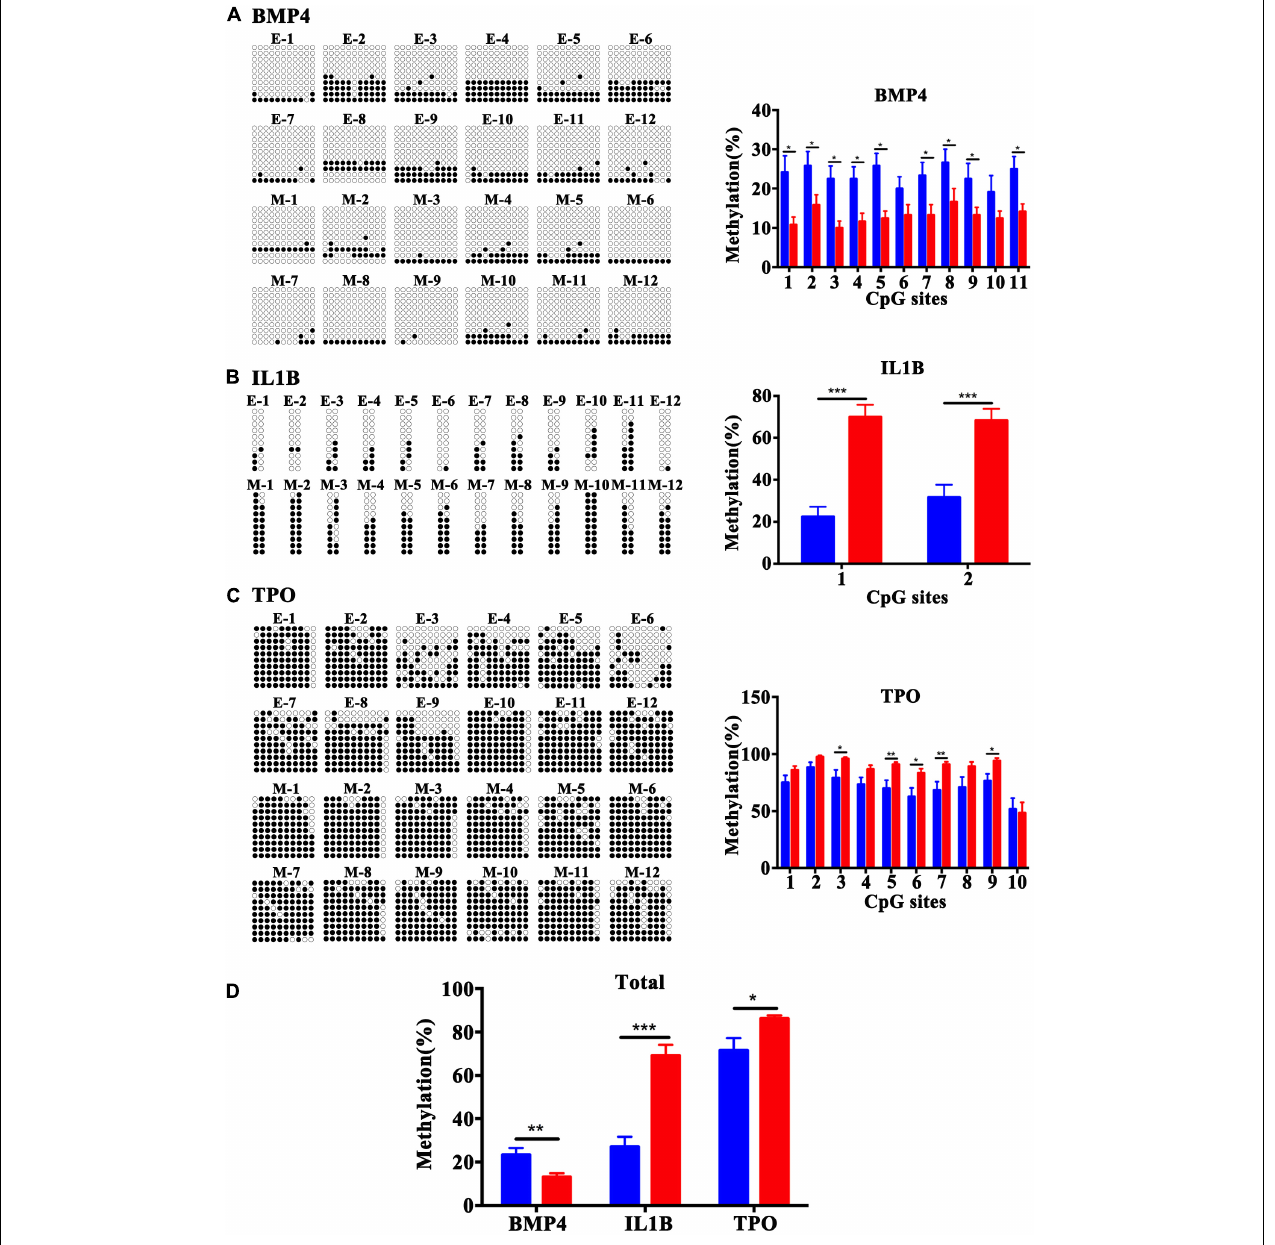
FIGURE 7 | Validation of the methylation levels by bisulfite sequencing in BMP4, IL1B, and TPO DMRs at base-pair resolution. Open circles and filled circles represent unmethylated and methylated CpG sites, respectively. (A) Bisulfite sequencing data for 11 CpG sites at the gene bodies of BMP4. (B) Bisulfite sequencing data for 2 CpG sites in the TSS1500 to TSS200 regions of IL1B. (C) Bisulfite sequencing data for 10 CpG sites at the 1st exon and 5 (cid:48) UTR of TPO. (D) Total methylation rate of BMP4, IL1B and TPO. The blue square represents the ETP group and red represents the MFPR group. Data are presented as mean ± SEM. * p < 0.05; ** p < 0.01; *** p <